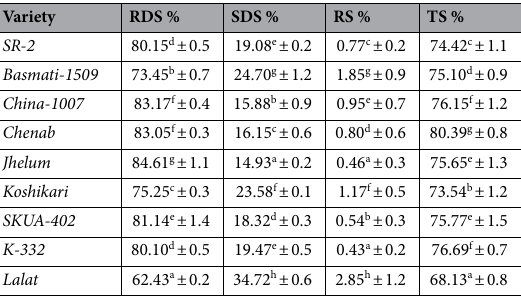
reported by Park et al. 37 for Korean rice cultivars with different amylose contents and Chen et al. 30 for low, inter- mediate and high amylose rice varieties of United States. However, Koshikari despite being a low amylose variety also showed higher RS content (1.17%) (Table 4), which can be attributed to its relatively higher fat (0.86%) (Table S1) and dietary fiber (DF) content (3.45%) (Table 2). Table 3 also indicated significant positive correla- tions of RS with fat (r = 0.707, p < 0.05). Besides RS, fat content also showed significant positive correlation with SDS (r = 0.673, p < 0.05) and negative correlation with RDS (r = − 0.831, p < 0.01) Since, interaction of amylose content and lipid fraction is responsible for formation of type-5 RS. Thus, the inference drawn was that it is not only the amylose content but its interaction with lipids which attenuates the glycemic response. The correlation studies given in Table 3 also indicated that RS is more significantly correlated with pGI (r = − 0.949, p < 0.01) as compared to AAC. Both RS and DF act in a complementary way in lowering the glycemic response 15,38 . Within the digestive tract, both RS and DF are more resistant to digestion and thus, help in lowering the blood glucose levels. In the present study, DF showed significant positive correlations with RS (r = 0.797, p < 0.05), and SDS (r = 0.880, p < 0.01) whereas, RDS showed significant negative correlation with DF (r = 0.928, p < 0.01) (Table 3). Predicted glycemic index and glycemic load. Kinetics of starch digestion analyzed for 0–180 min given in Fig. 2a revealed a rapid increase in the digestibility of starch during first 30 min of incubation followed by a steady digestion rate with the progression of time. The predicted GI values of different rice varieties ranged from 50.12 ( Lalat ) to 84.22 ( K-332 ) (Fig. 2b). As per WHO 39 classification, SR-2, China-1007, Chenab, Jhelum, SKUA-402 and K-332 were classified as high GI varieties (GI ≥ 70); Basmati-1509 and Koshikari as medium GI varieties (GI = 56–69) and Lalat as low GI variety (GI ≤ 55), All the medium slender, long bold and short bold varieties elicited high GI scores which is in accordance with the results reported by Prasad et al. 15 for popular Indian rice varieties. Although being a short bold variety, Koshikari showed intermediate pGI score of 63.11, which can be attributed to its higher RS, DF, fat and protein contents as compared to other short bold varieties (Table S1 and Table 2). Amylose fraction of starch in combination with lipid fraction forms type-5 resistant starch 40 . In addition, interaction between starch, lipids and proteins result in the formation of highly